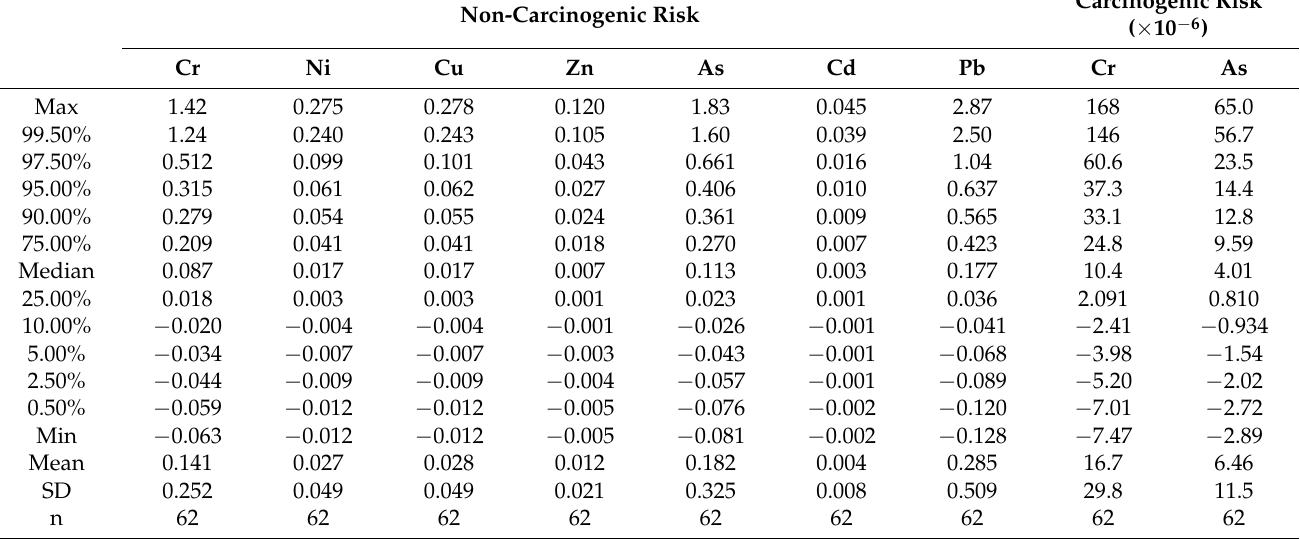
Table 3. The estimated children’s health risk assessment results for heavy metal soil pollution in this area based on the data on children’s soil intake obtained from this study. Non-Carcinogenic Risk